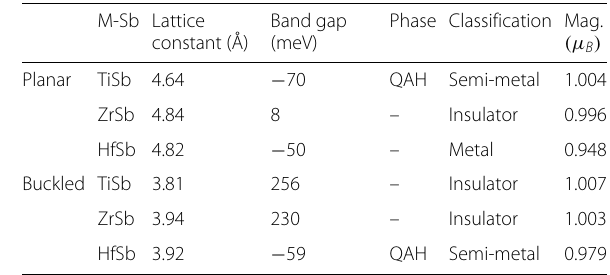
Table 1 Calculated equilibrium lattice constants, system band gaps, magnetic moment, and topological phase of planar and buckled M-Bi honeycombs